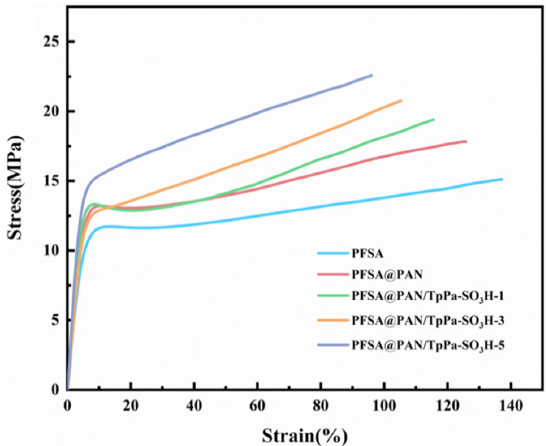
Figure 9. Mechanical property of membranes at 25 °C.